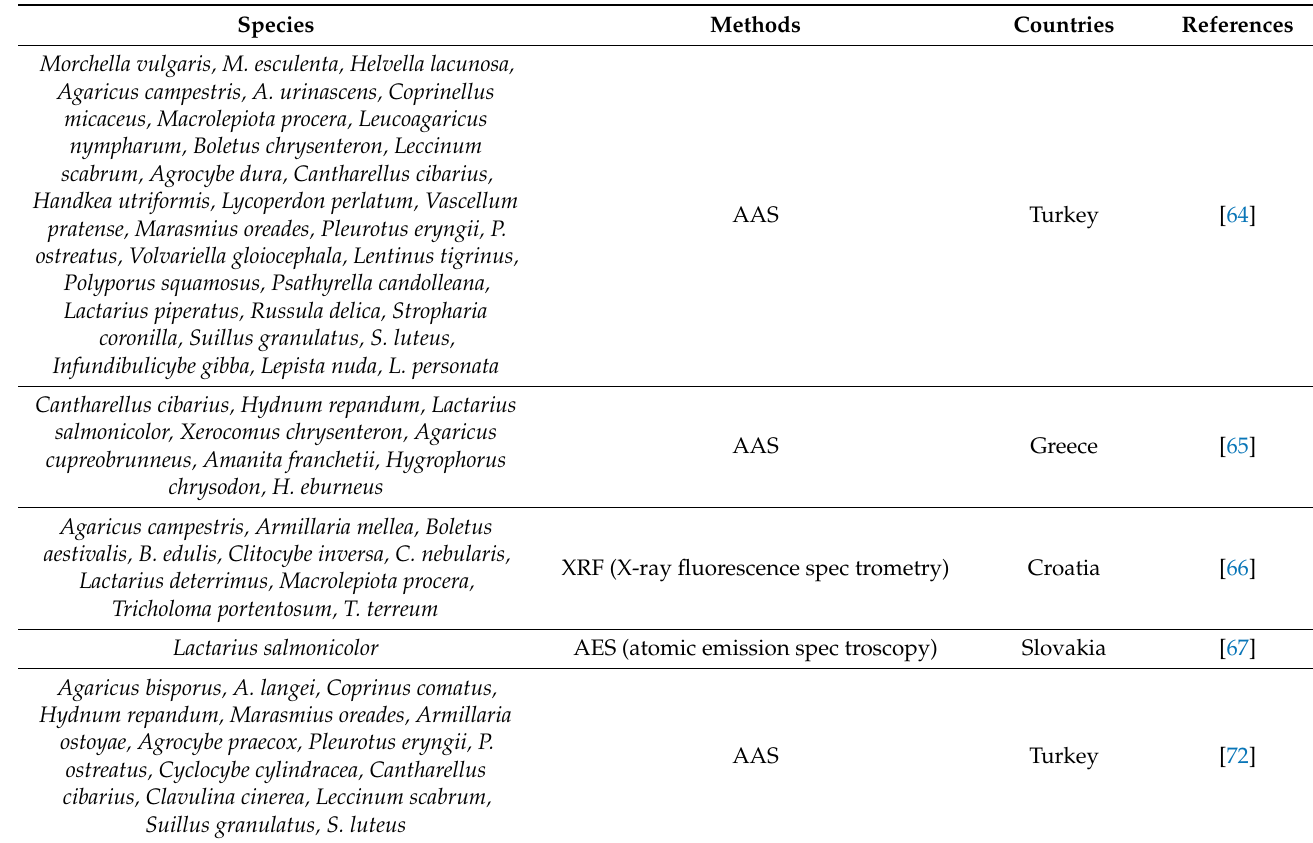
Table 4. Species, methods for determination of zinc, and countries in the literature.